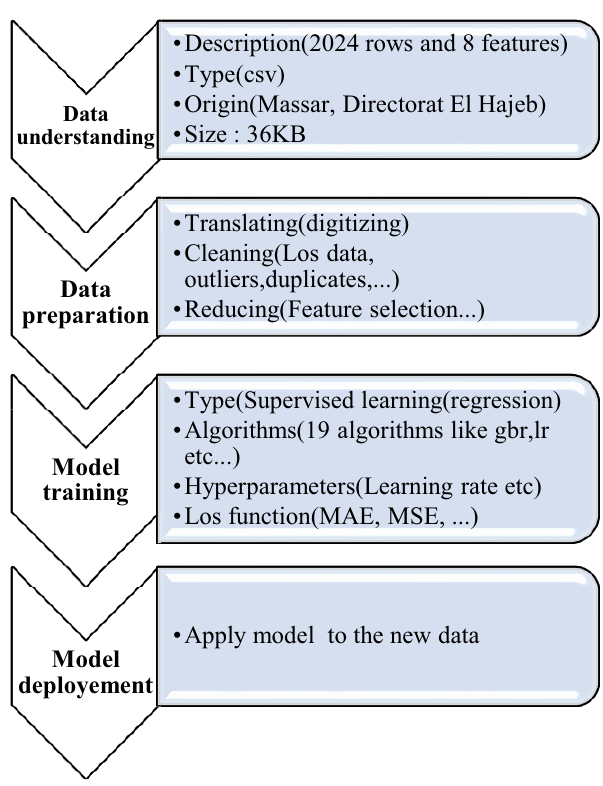
Figure 1 Framework for Data Preparation